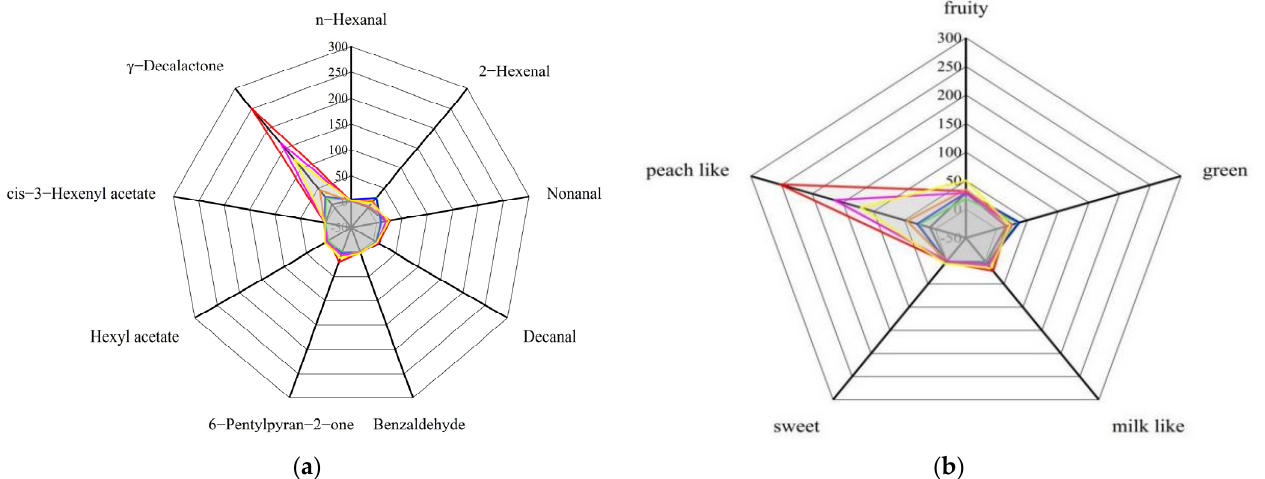
Figure 6. ( a ): The flavor analysis of seven peach cultivars. Nine important aroma compounds of flat peach (yellow line), liguang peach (green line), honey peach (blue line), yellow peach (black line), yellow nectarine (purple line), red nectarine (red line) and shoutao (orange line). ( b ): Flavor analysis of the main volatile compounds in seven peach cultivars. The flavor analysis of flat peach (yellow line), liguang peach (green line), honey peach (blue line), yellow peach (black line), yellow nectarine (purple line), red nectarine (red line) and shoutao (orange line).